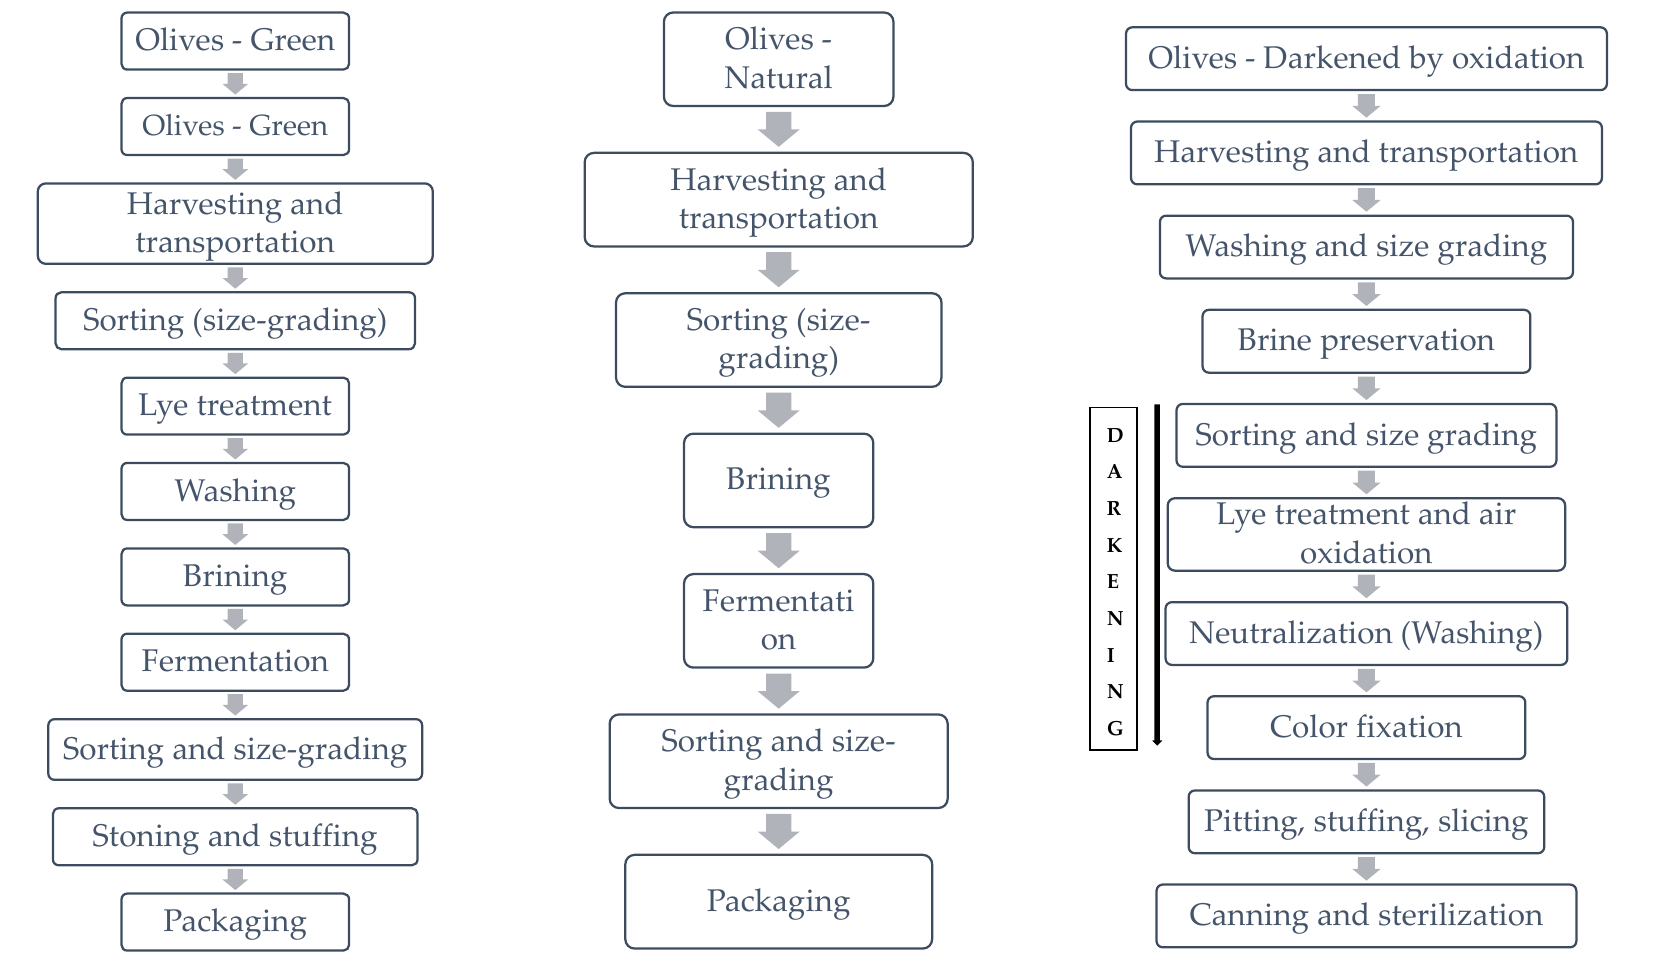
Figure 1. Flow sheets of processing of treated green, natural and darkened by oxidation olives.